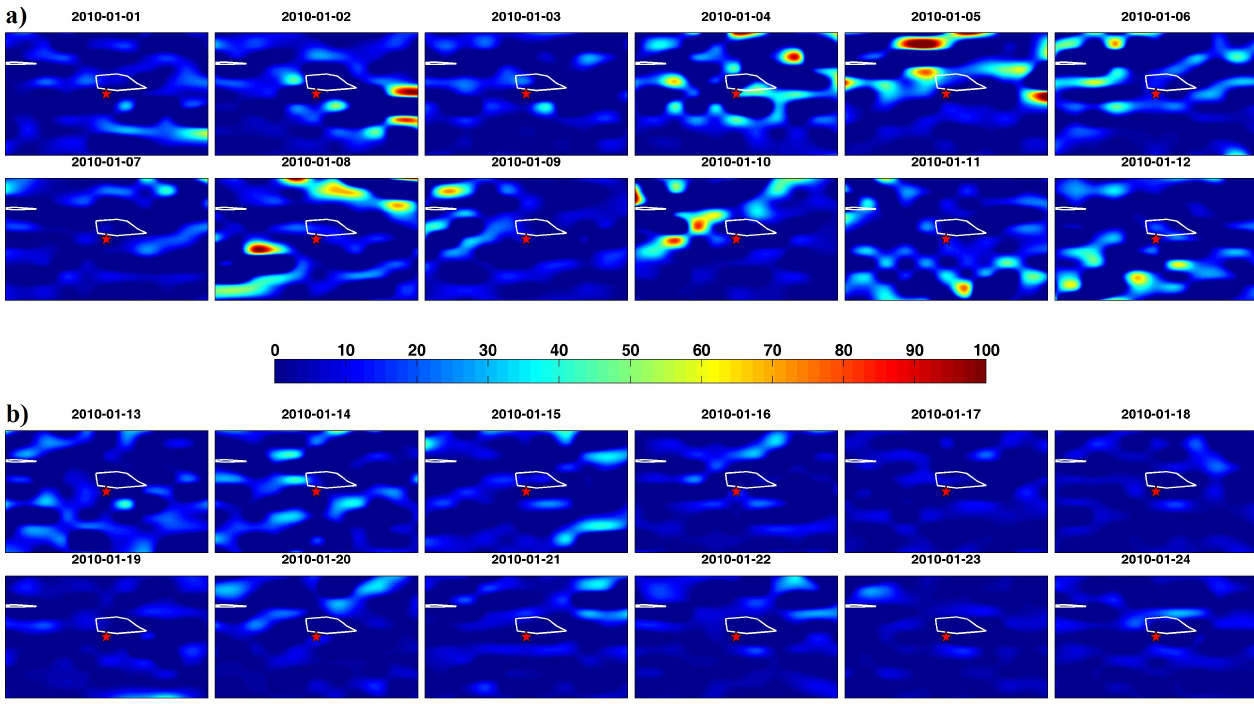
Fig. 2. Eddy field OLR (day data) curves (a) from 1 to 12 January 2010, before Haiti earthquake, (b) from 13 to 24 January 2010, after Haiti earthquake. Epicenter is marked with red star, tectonic plate boundaries with white line, Longitude from 282.5 ◦ to 292.5 ◦ , Latitude from 13.5 ◦ N to 23.5 ◦